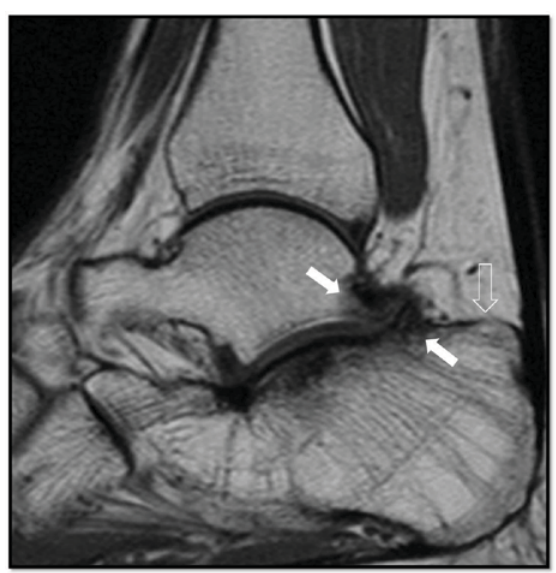
Figure 1. Sagittal T1-w MR image, showing the marrow edema in opposing bony protuberances (arrows). Note Haglund’s deformity in calcaneus (open arrow).